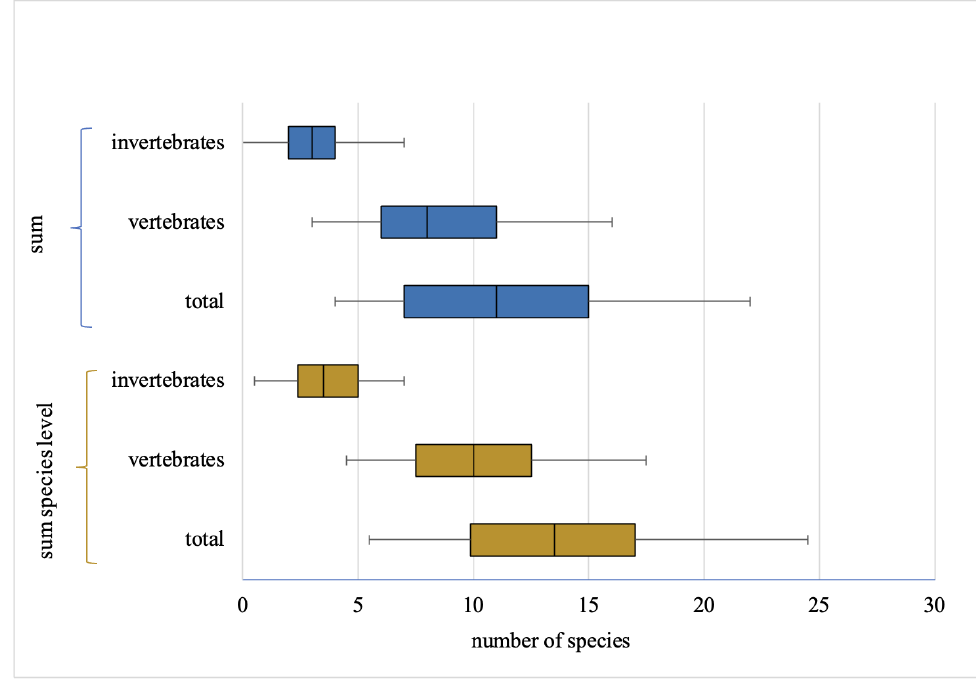
Figure 1. Boxplots of the achieved sum (inclusive genus/family level) and the sum on species level (both in total and for vertebrates/invertebrates) in the species knowledge test. Table 3. The number of students (in%) who were able to identify the respective species at the species level.